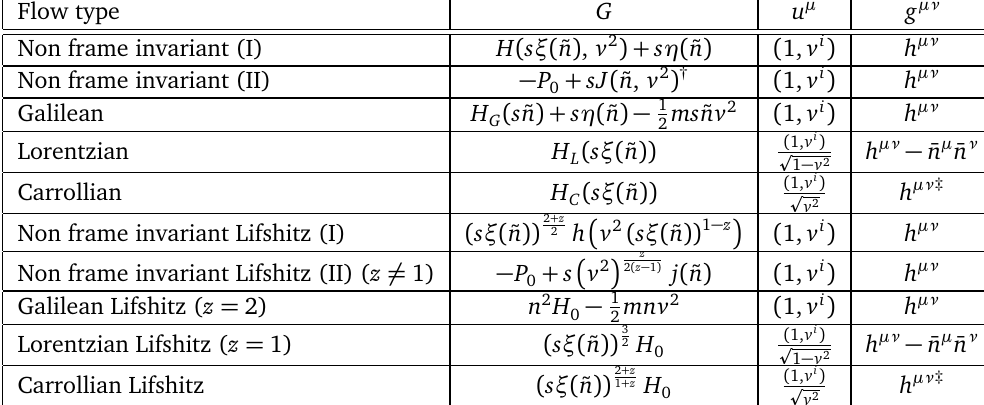
Table 2: Constraints on the form of the free energy G , the velocity field, u µ and µρ g νσ needed in order to construct a conserved enstrophy cur- Ω 2 = Ω Ω µν ρσ g α (cid:0) s (cid:1) ( Ω 2 ) u µ . Here, G is a free energy related to the pressure, P , rent J µ = q n s 2 α − 1